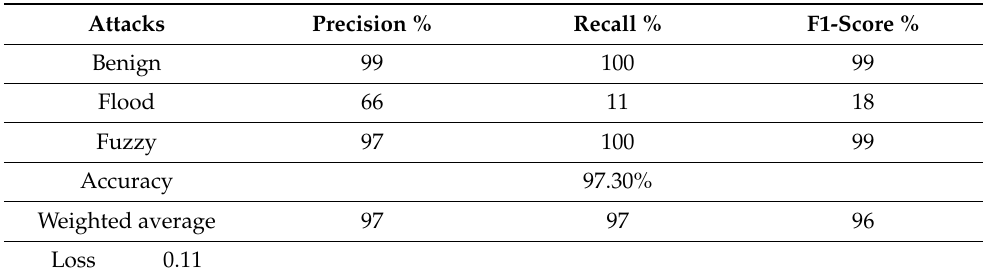
Table 10. Results of the CNN-LSTM model for the detection of the flood, fuzzing, and normal packets in a CAN